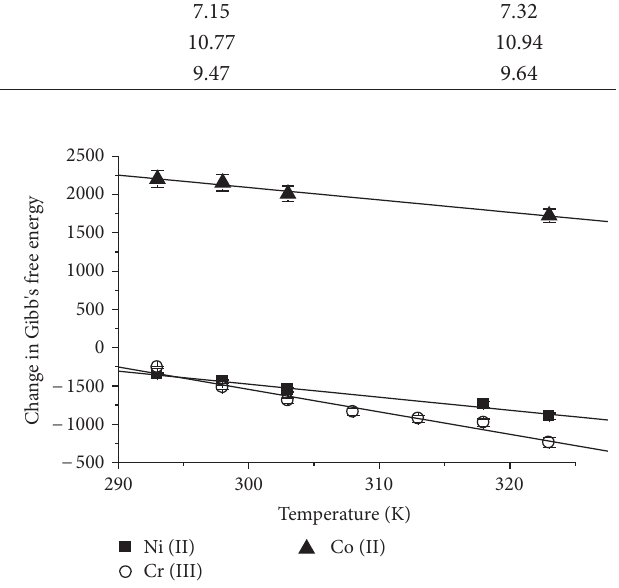
F 8: ermodynamic plots for the biosorption of Ni(II), Cr(III), and Co(II) onto Acalypha hispida